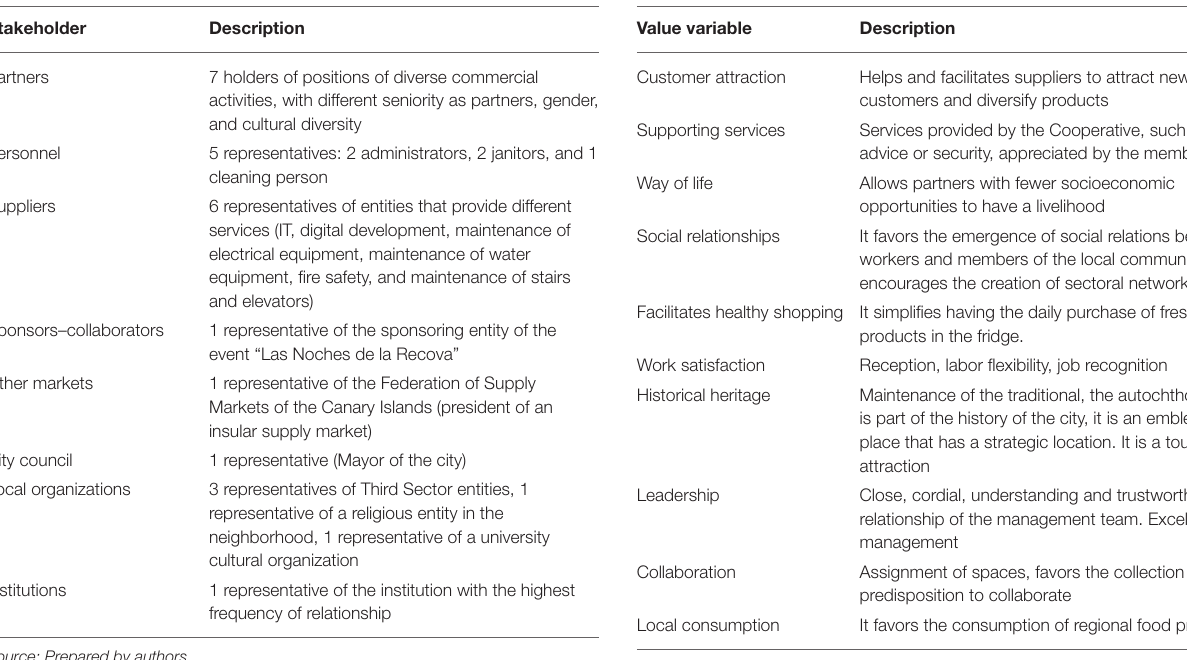
TABLE 2 | Interviews with representatives of the Cooperative’s stakeholders. TABLE 3 | Description of the value